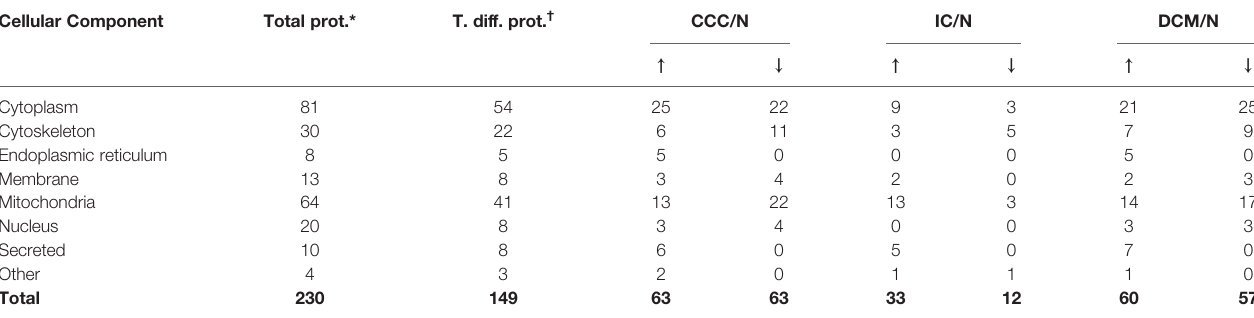
TABLE 2 | Cellular component classi fi cation of the proteins differentially expressed in the myocardium from patients with CCC, IC and DCM. Cellular Component Total prot.*